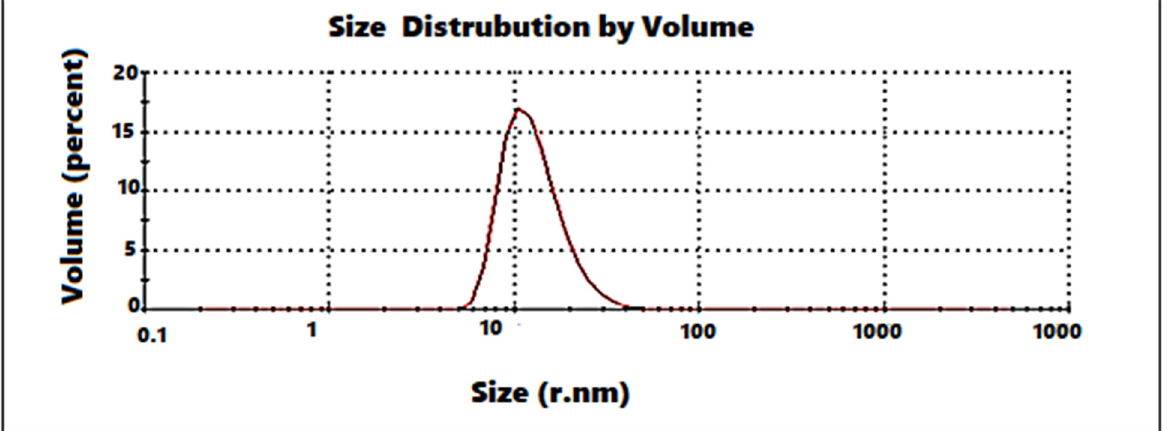
Figure 2: DLS result for the green - synthesized A. digitata